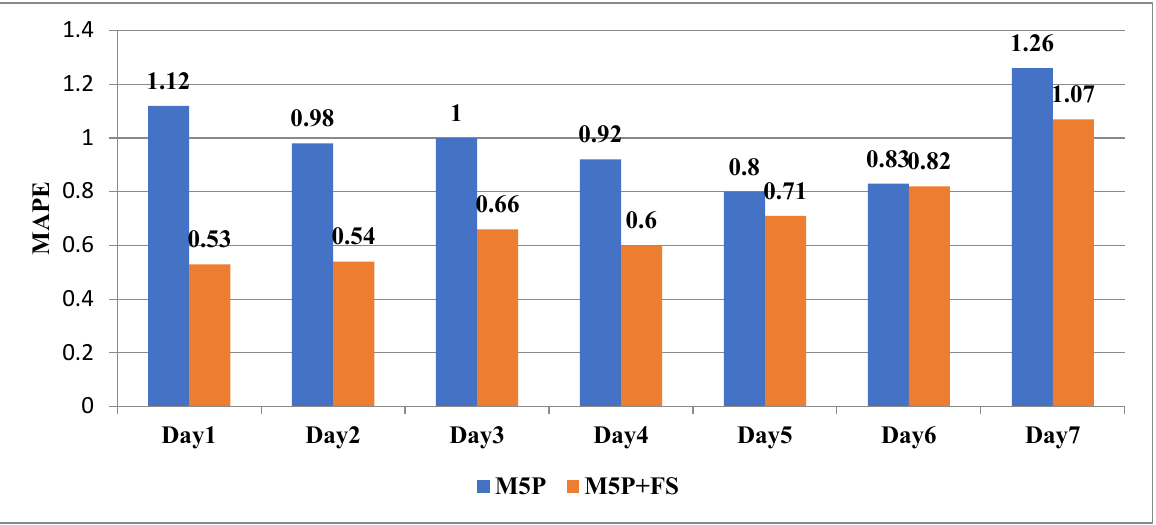
Figure 7. Representation of daily MAPE for winter season corresponding to M5P and M5P + FS.